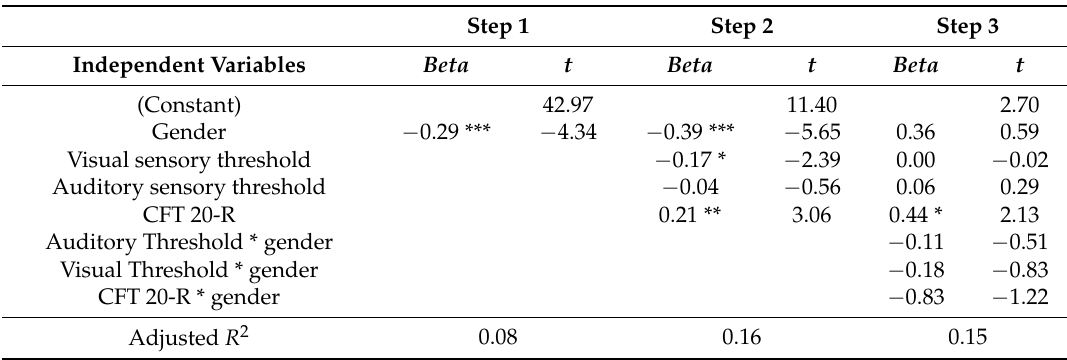
Table 3. Multiple regressions predicting GERT-S scores from gender, visual and auditory sensory threshold, and psychometric